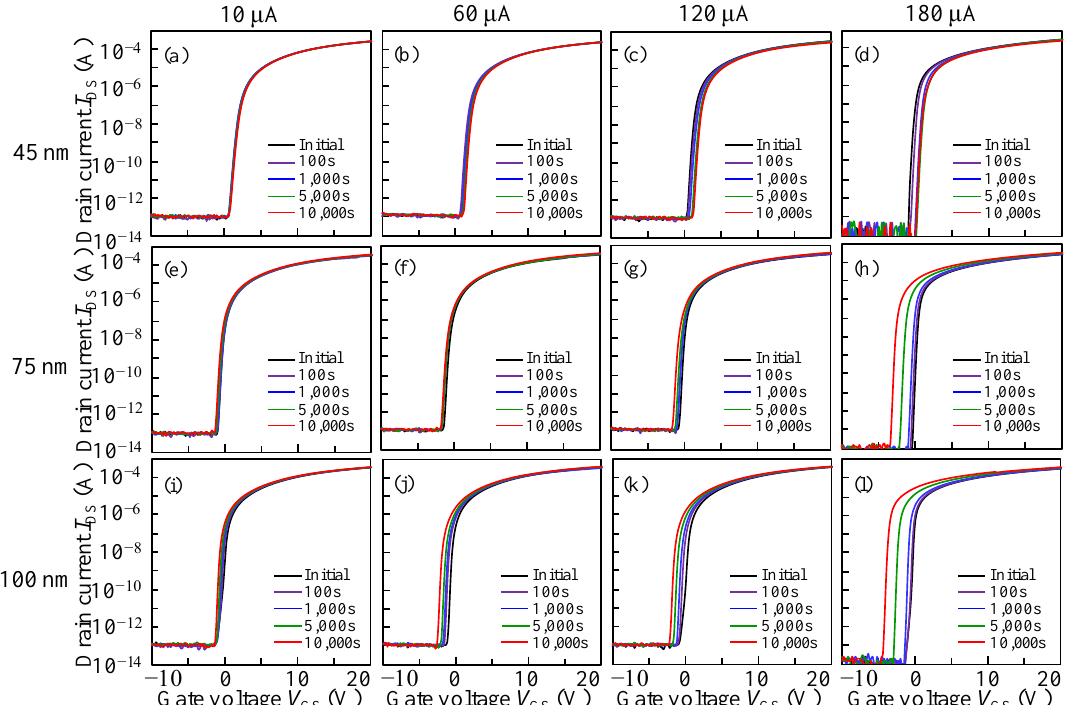
Figure 6. Evolution of transfer characteristics as a function of 10 4 s DCS duration with the test temperature of 50 °C for the devices with a T ITZO of 45 nm under I DS stresses of (a) 10, (b) 60, (c) 120, and (d) 180 μA; with a T ITZO of 75 nm under I DS stresses of (e) 10, (f) 60, (g) 120, and (h) 180 μA; and with a T ITZO of 100 nm under I DS stresses of (i) 10, (j) 60, (k) 120, and (l) 180 μA.